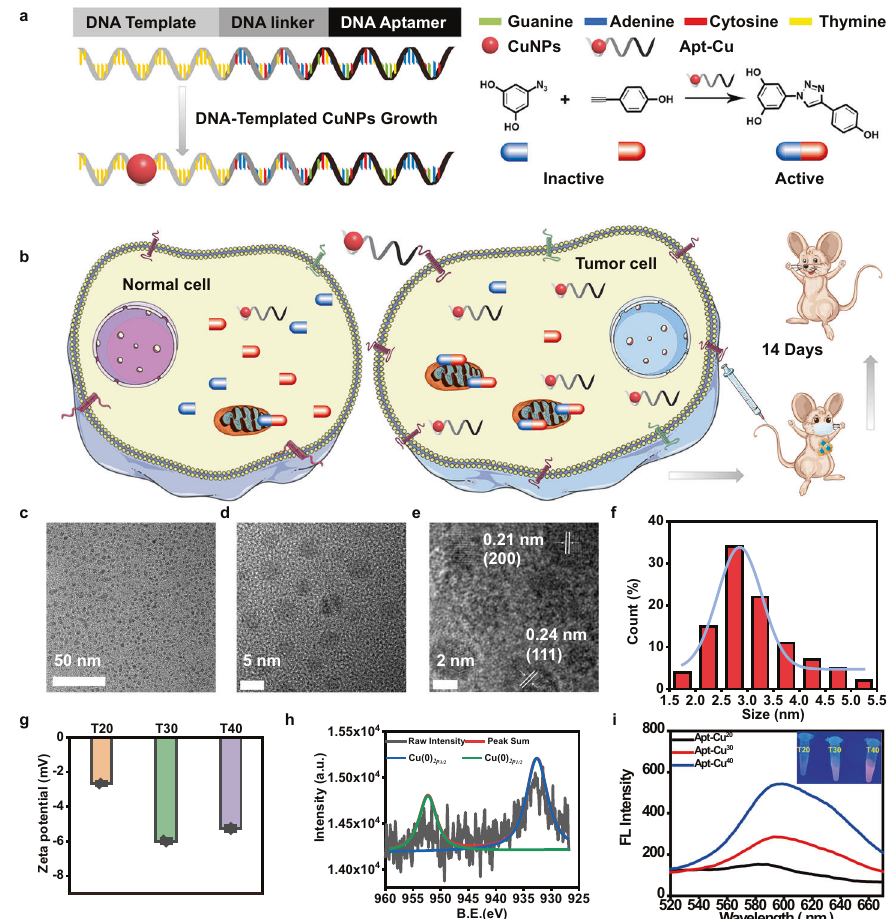
Fig. 1 Design and characterization of DNA-based bioorthogonal catalyst. a Illustration of the design and synthesis of DNA-templated CuNPs as bioorthogonal catalyst. b Aptamer-mediated CuNPs for cell-speci fi c identi fi cation and targeted cancer therapy in vivo; ( c ) Transmission electron microscopy (TEM) image of Apt-Cu 30 . d , e High-resolution TEM images of Apt-Cu 30 . f Histogram of size distribution of Apt-Cu 30 . The total number of nanoparticles counted was 100. g Zeta-potentials of Apt-Cu 20 , Apt-Cu 30 , and Apt-Cu 40 in H 2 O (pH 6.6). Data were presented as mean ± SD ( n = 3 independent experiments). h XPS spectra of Apt-Cu 30 (red line: fi tting curve). i Fluorescence spectra of Apt-Cu 20 , Apt-Cu 30 and Apt-Cu 40 excited at 340 nm. (Inset) Photographs of Apt-Cu under UV lamp. Source data are provided as a Source Data fi